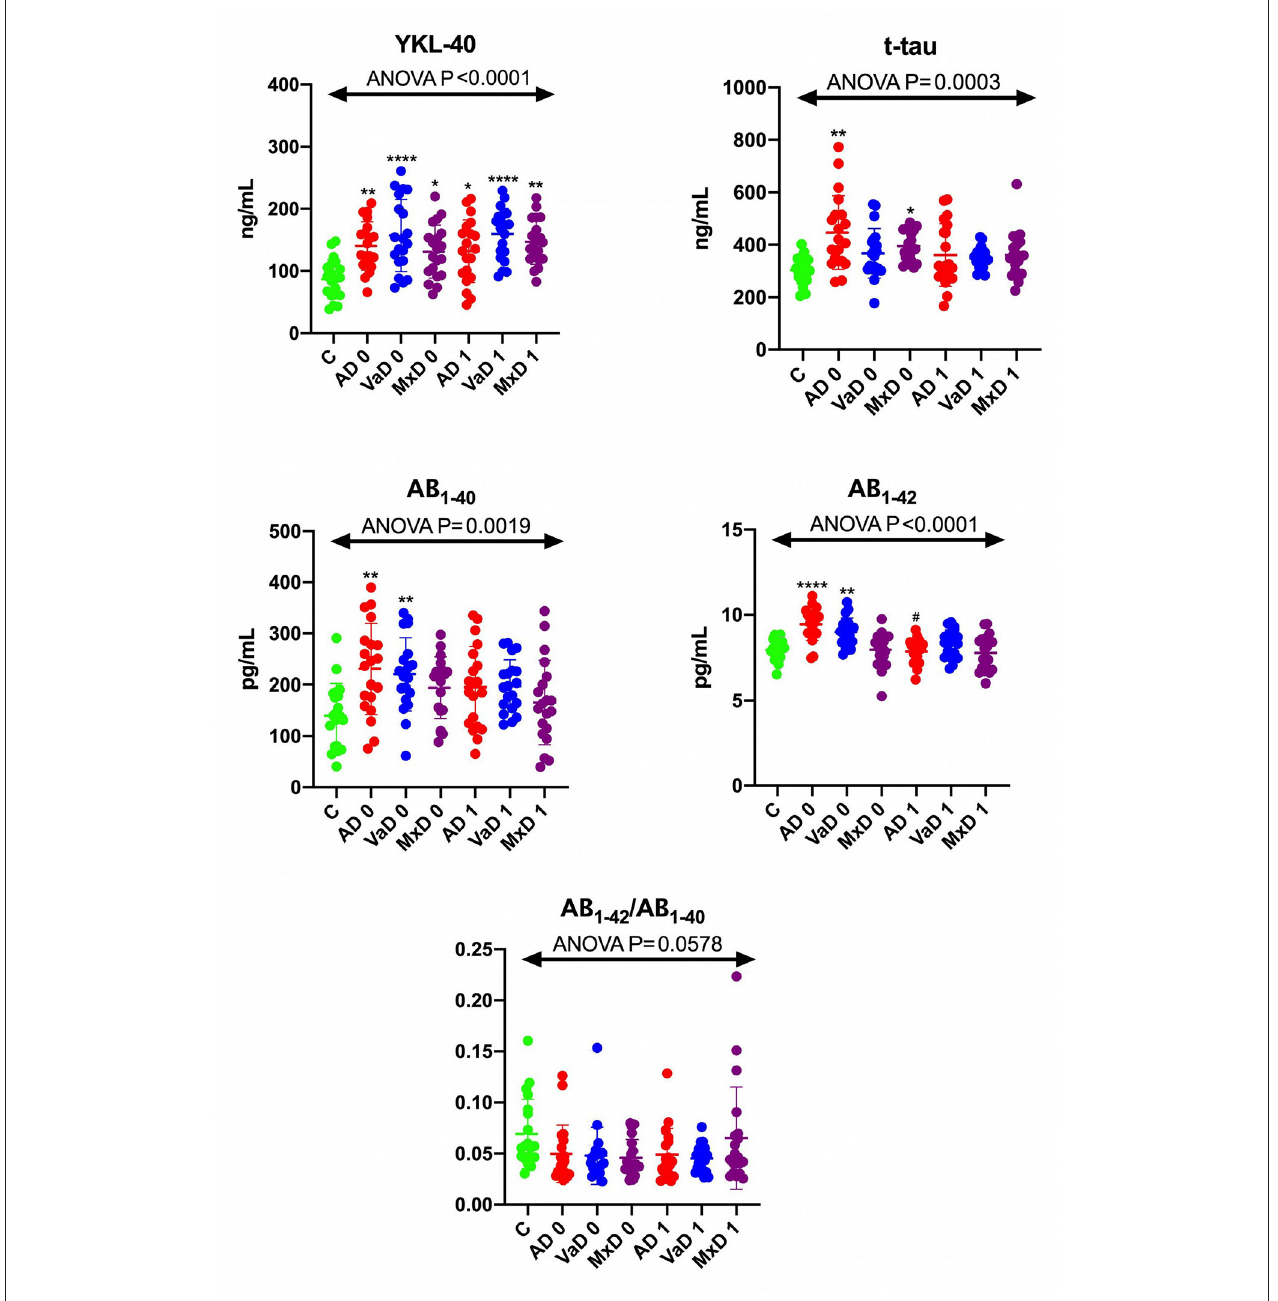
FIGURE 2 | Biomarker concentrations in control and dementia patients on admission and after 4 weeks of treatment. Results are presented as mean, standard deviation (SD) and individual values. C, control group ( n = 20); AD 0, patients with Alzheimer’s dementia on admission ( n = 20); VaD 0, patients with vascular dementia on admission ( n = 20); MxD, patients with mixed dementia on admission ( n = 20); AD 1, patients with Alzheimer’s dementia after 4 weeks of treatment ( n = 20); VaD 0, patients with vascular dementia after 4 weeks of treatment ( n = 20); MxD, patients with mixed dementia after 4 weeks of treatment ( n = 20). * p < 0.05 vs. C, ** p < 0.005 vs. C, **** p < 0.0001 vs. C, # p < 0.05 vs. AD